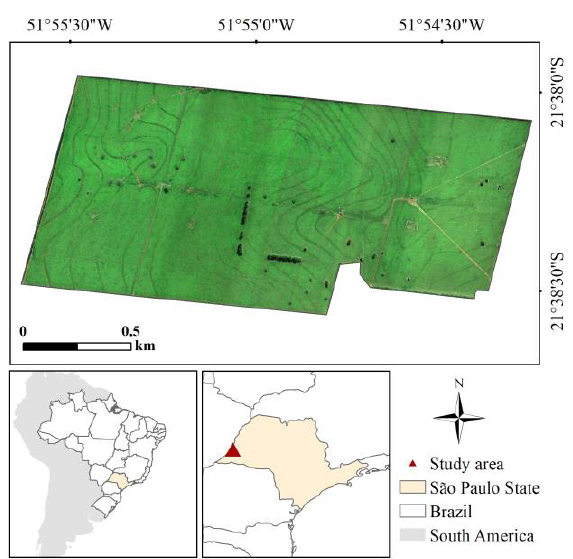
Figure 1. Location of the study area in the western region of the state of São Paulo, Brazil, and the UAV orthomosaic (true colour composite red-green-blue (RGB):321) of the study area in August 2019.